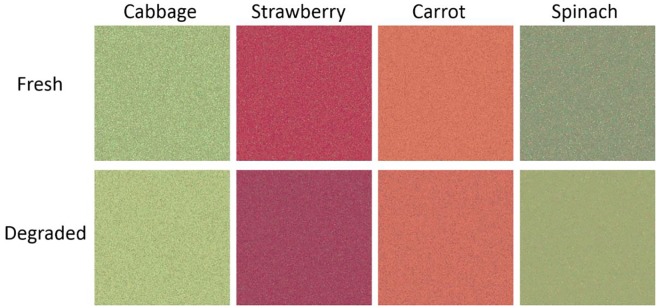
Stimuli used in Experiment 2.